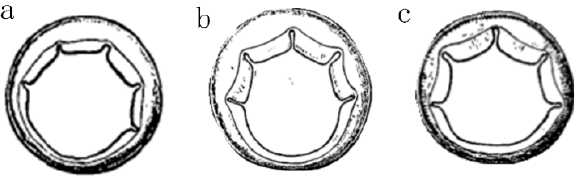
Figure 6. Sucker ring of type specimen from L. ( N. ) beka (Sasaki, 1929) 38. ( a ) proximal most sucker; ( b ) largest sucker; and ( c ) a distal sucker.